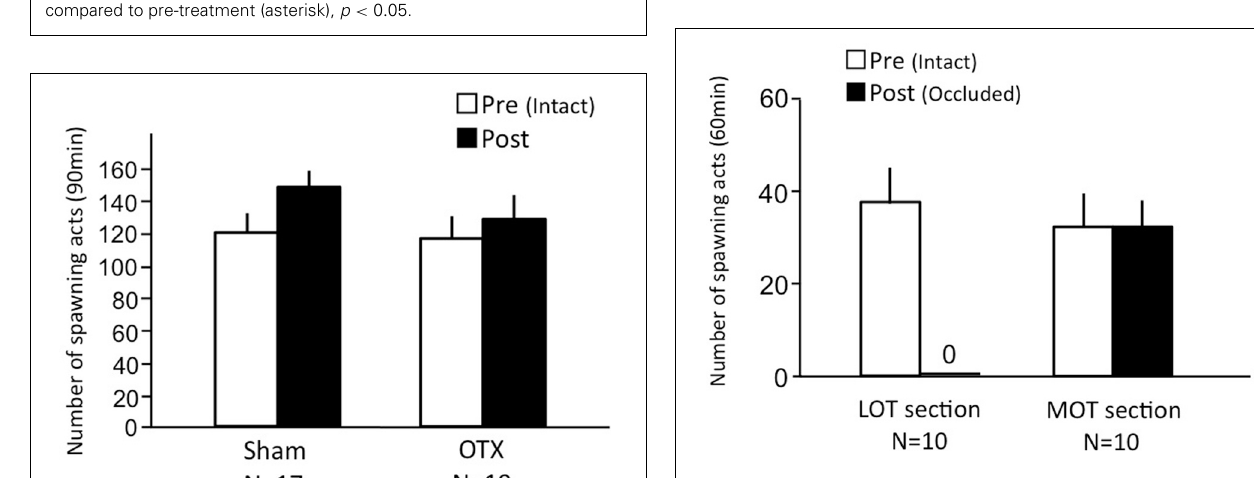
FIGURE 6 | Effects of olfactory subtract section on female sexual behavior in female goldfish. LOT section, Lateral olfactory tracts were sectioned. MOT, Medial olfactory tracts were sectioned. Pre-treatment (open column). Post, post-treatment (solid column). Each column represents the mean and